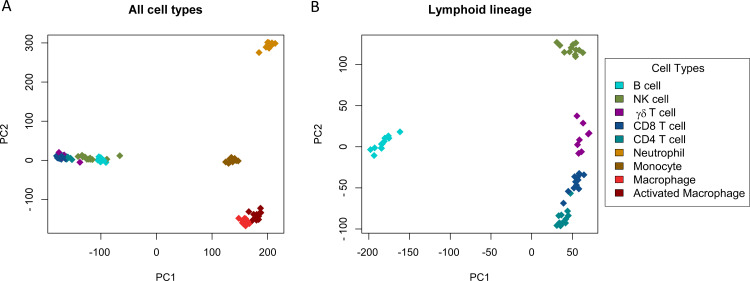
Transcriptomic data distinguish immune cell types.Representation of the first two principal components on RNA-seq data from all individuals for all samples (Panel A) and for lymphoid samples alone (Panel B). The R function prcomp was used to perform principal component analysis, and each symbol represents an individual RNA-seq sample.